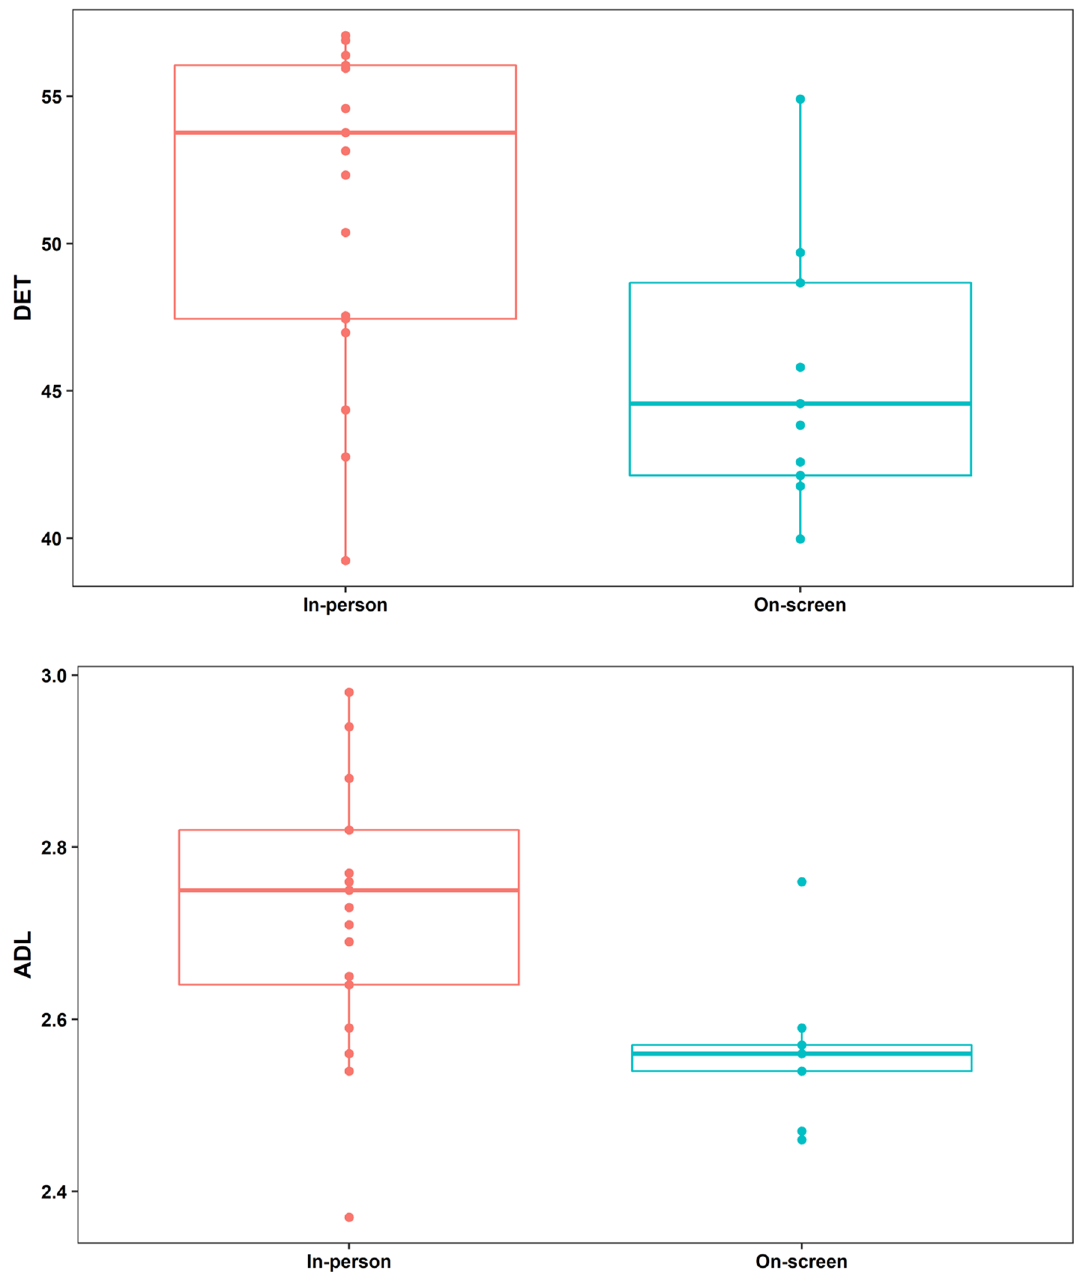
Figure 3. Boxplots of MdRQA outcomes. Large groups in the stadium displayed more physiological synchrony compared to small groups watching the games